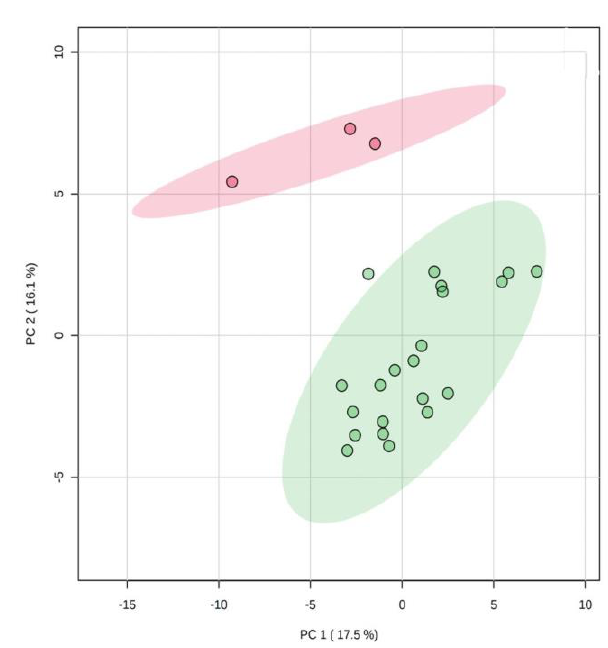
Figure 1. Principal component analysis (PCA) scores plot derived from serum metabolomics profiles of 24 patients with metastatic soft tissue sarcomas (STS). The patients clustered into two distinct groups, one with only 3 cases (red) and the other with the remaining 21 cases (green).